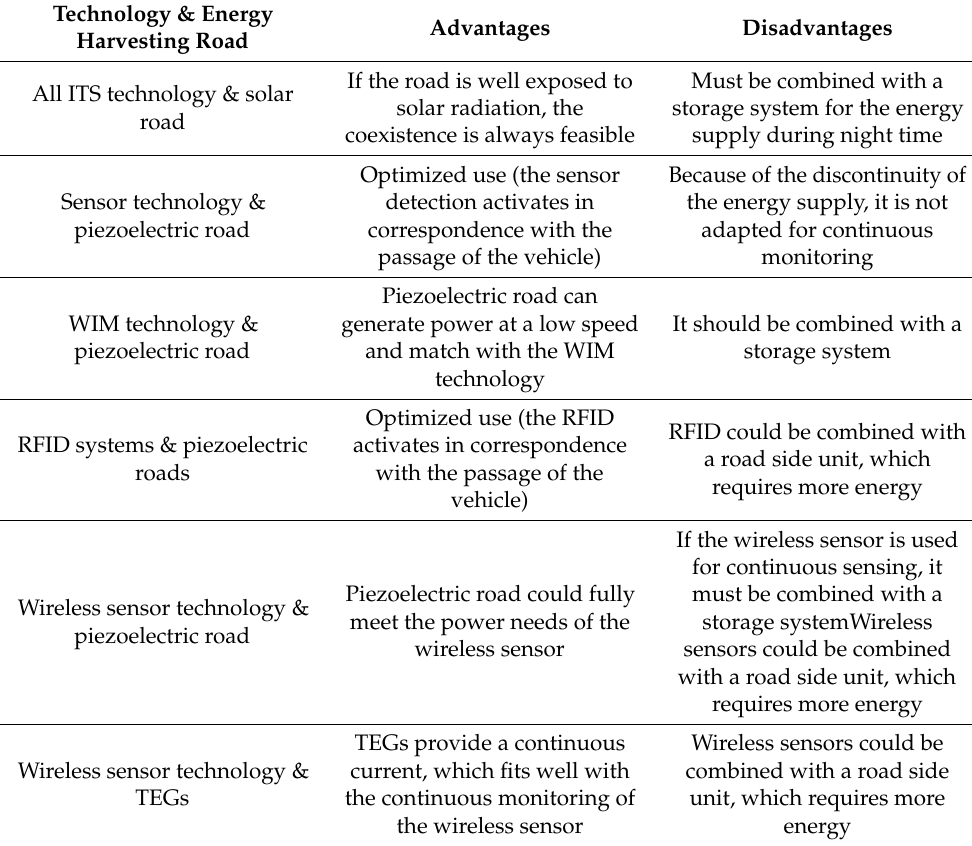
Table 10. Advantages vs disadvantages of the coexistence between energy harvesting roads and ITS